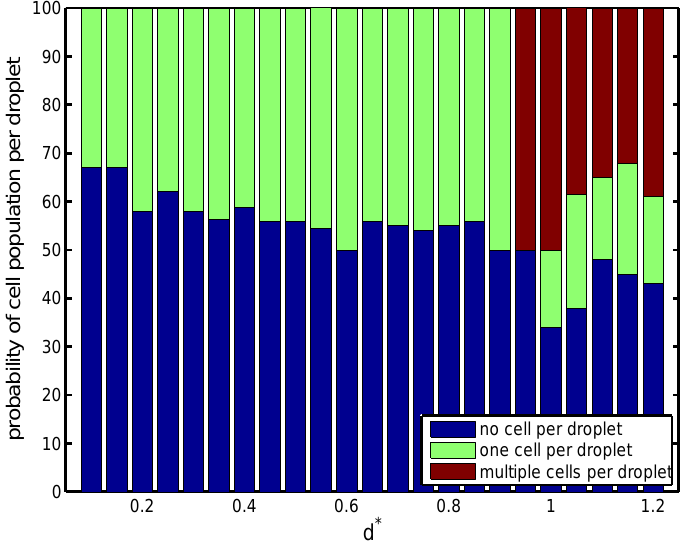
Figure 8. Probability of cell population per droplet (%) for configurations with different non-dimensional nozzle-to-orifice distances at Ca i = Ca o = 10 − 3 . Other geometrical parameters are kept fixed ( r ∗ = 0.25 and l ∗ =